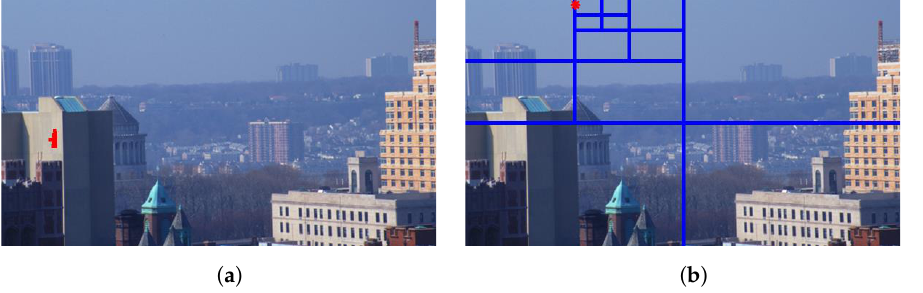
Figure 18. Atmospheric light estimation procedure utilized by: ( a ) Zhu et al. [52]–red pixels be- longs to the top 0.1% brightest pixels, and ( b ) Park et al. [121]—blue lines represent the quadtree- decomposition process, and the red dot represents the atmospheric light’s